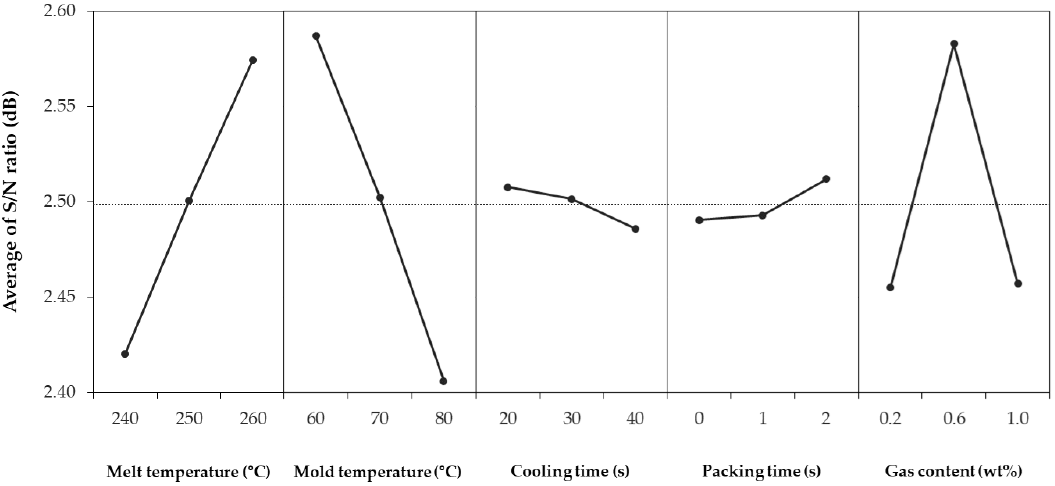
Figure 6. Average of S/N ratio for warpage. Table 5. Optimum condition defined by the Taguchi method. Optimization